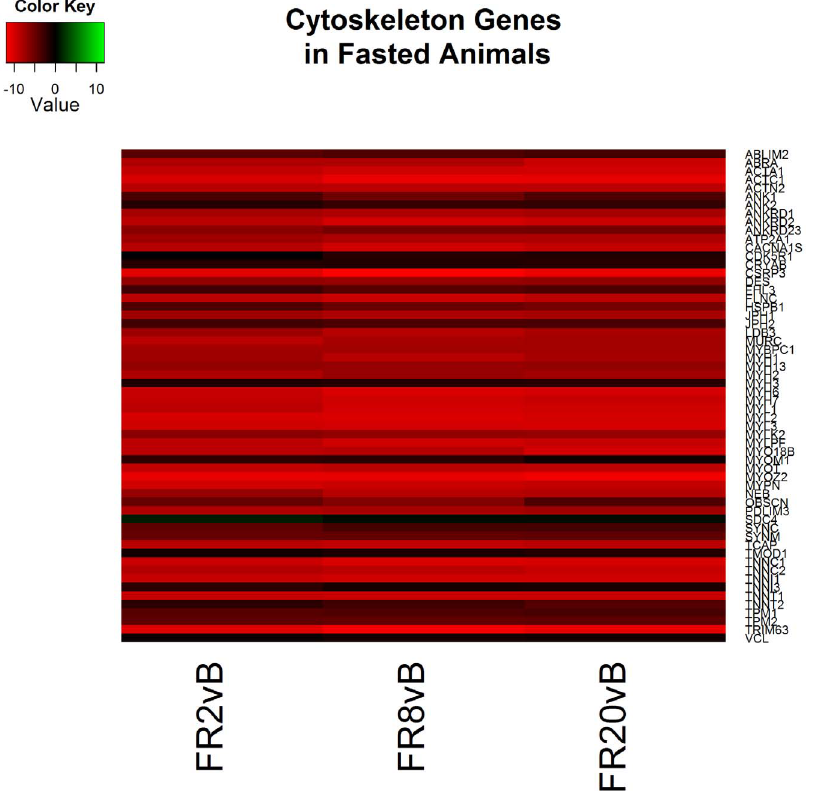
Figure 7. Heatmap of log2 fold changes of genes associated with cytoskeleton processes in fasted (FS) animals at each resuscitation timepoint (2, 8, and 20 hours) relative to Baseline (B). Rows are differentially expressed genes (DEGs) following RNA sequencing. Columns denote the respective timepoints Baseline (B), 2 hours full resuscitation change from Baseline (FR2vB), 8 hours full resuscitation change from Baseline (FR8vB), and 20 hours full resuscitation change from Baseline (FR20vB). Green denotes increased mRNA expression with respect to Baseline whereas red denotes the opposite.